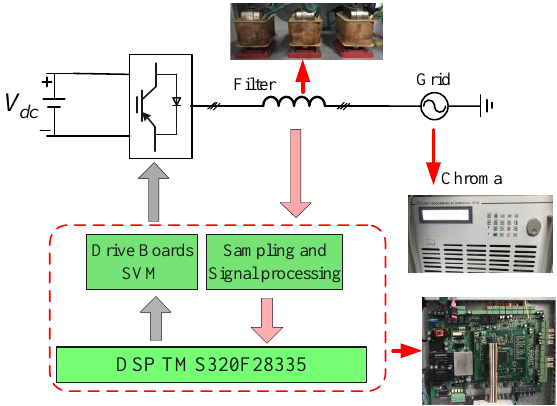
Figure 8. Schematic diagram of the experimental system.